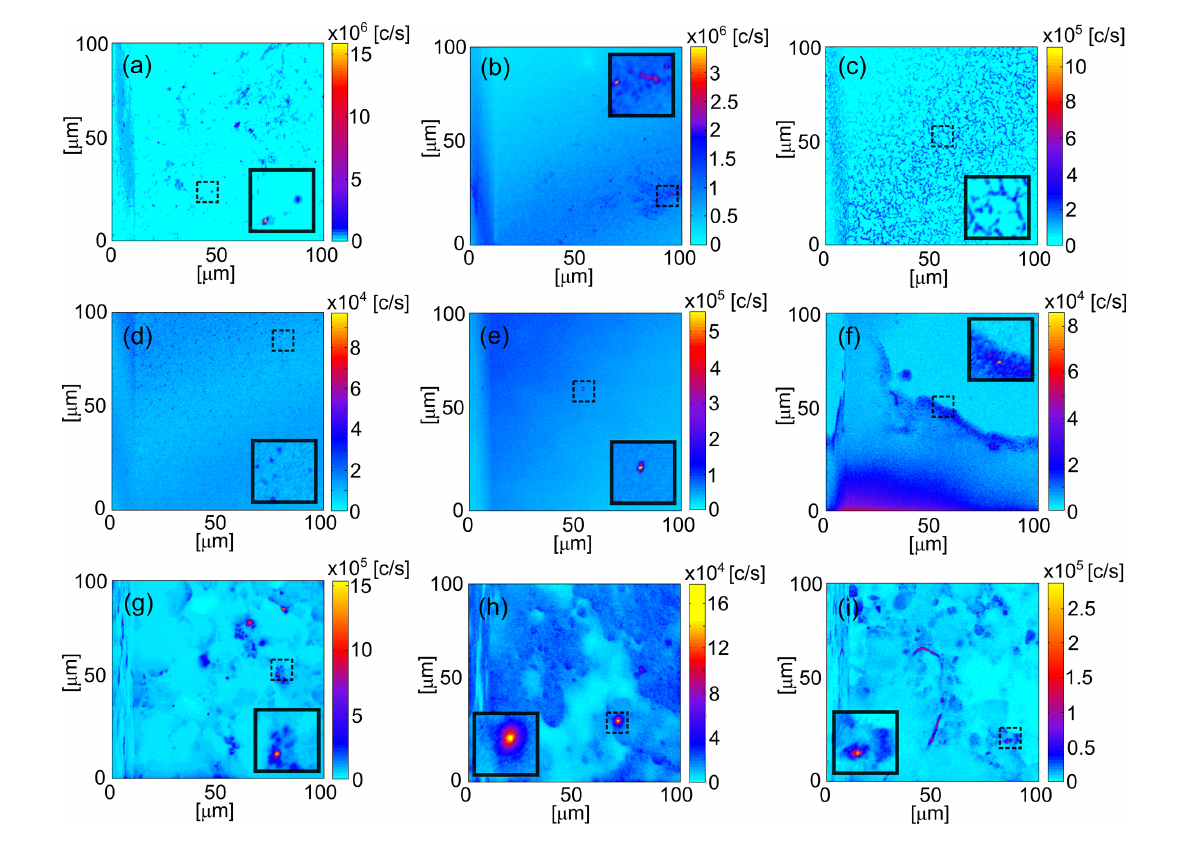
Figure 2: Representative 100 × 100 μ m 2 confocal scans of TiO 2 morphologies. E-beam deposited thin films: (a) NA-TiO 2 , (b) a-450 °C-TiO 2 , (c) 850 °C-TiO 2 and (d) b-450 °C-TiO 2 . (e) Single crystal rutile(001) with edges of . Nanopowder samples: (f) rutile + DI water; (g) anatase + DI water; (h) rutile + IPA and (i) anatase + IPA. The colour bars represent the count rate at the detector for each sample. The solid line black box